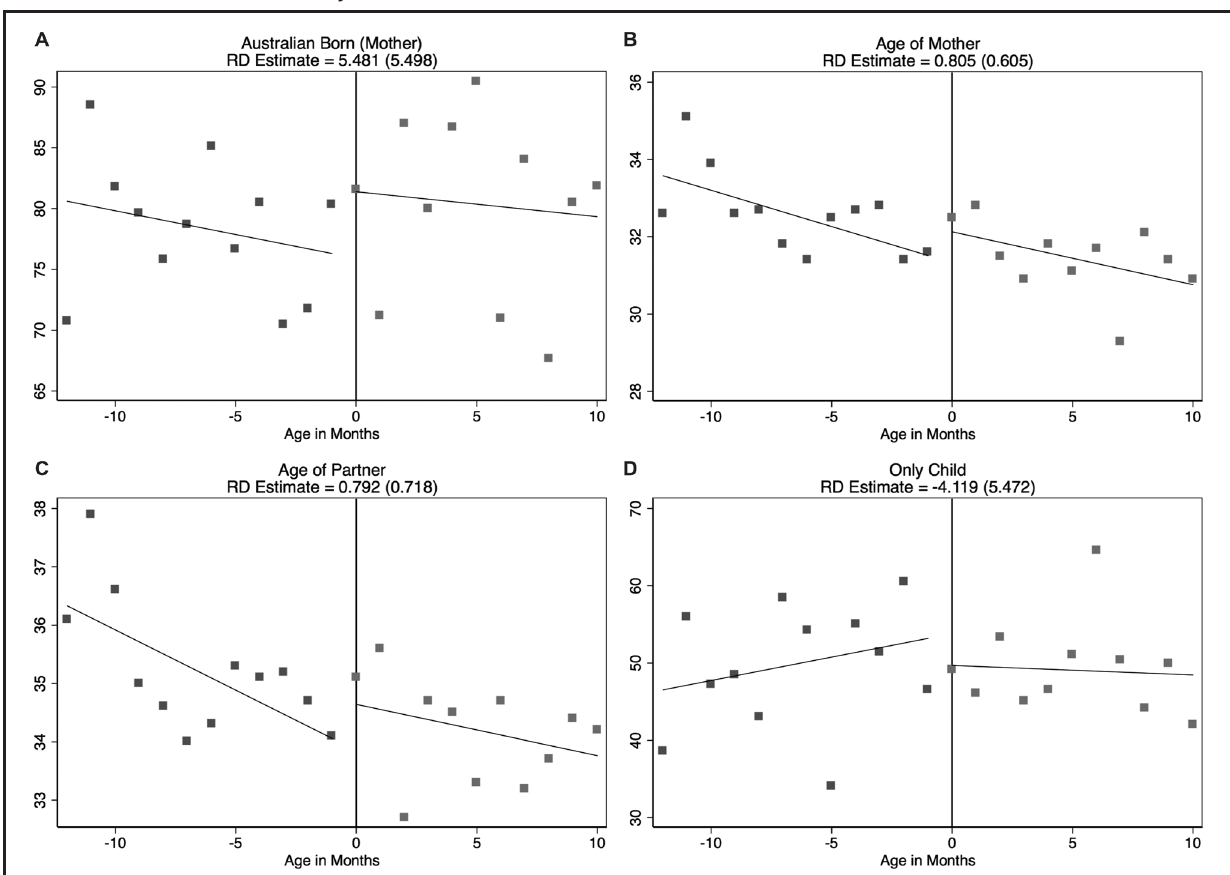
Figure 5 Balance in covariates around the January 1 2011 threshold: (A) Percentage of mothers who are Australian born. (B) Average age of the mother. (C) Average age of the mother’s partner. (D) Percentage of mothers with only one